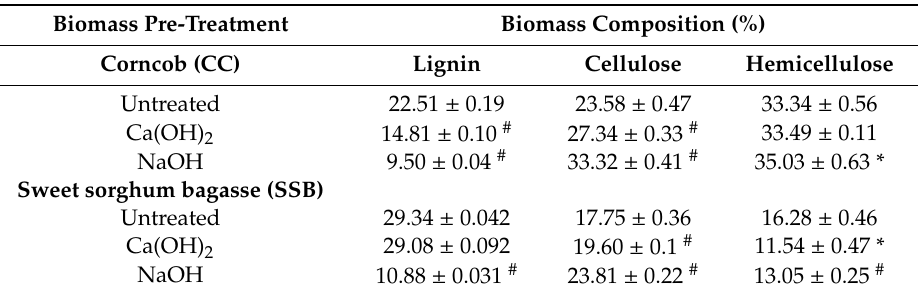
Table 1. Alkaline pretreated feedstock compositional